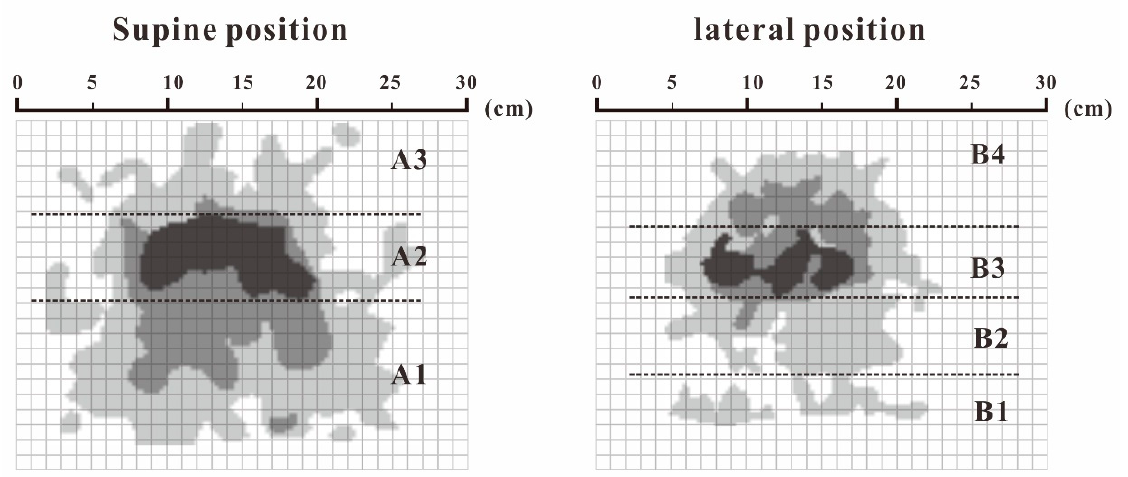
Figure 3. Ideal pressure distribution matrix partition.